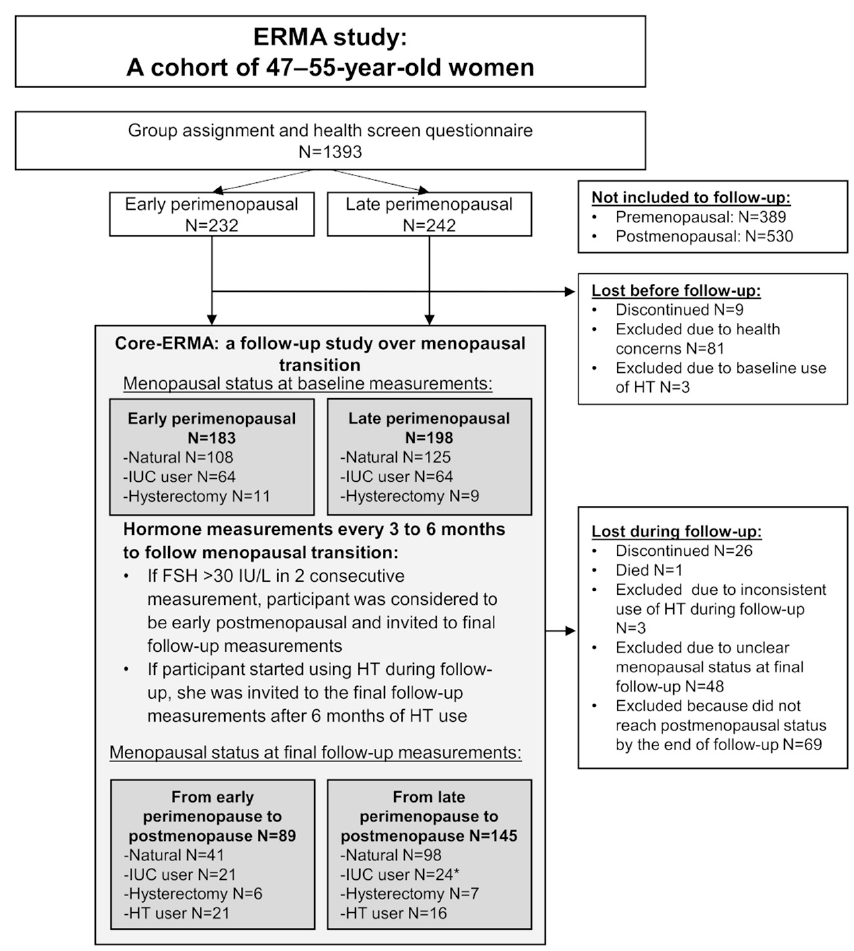
Figure 2. Flow chart of the longitudinal Estrogenic Regulation of Muscle Apoptosis (ERMA) study. FSH, follicle stimulating hormone; HT, hormone replacement therapy; IUC, intra-uterine hormonal contraceptive. *One former IUC user did not inform us if her IUC-status had changed during follow-